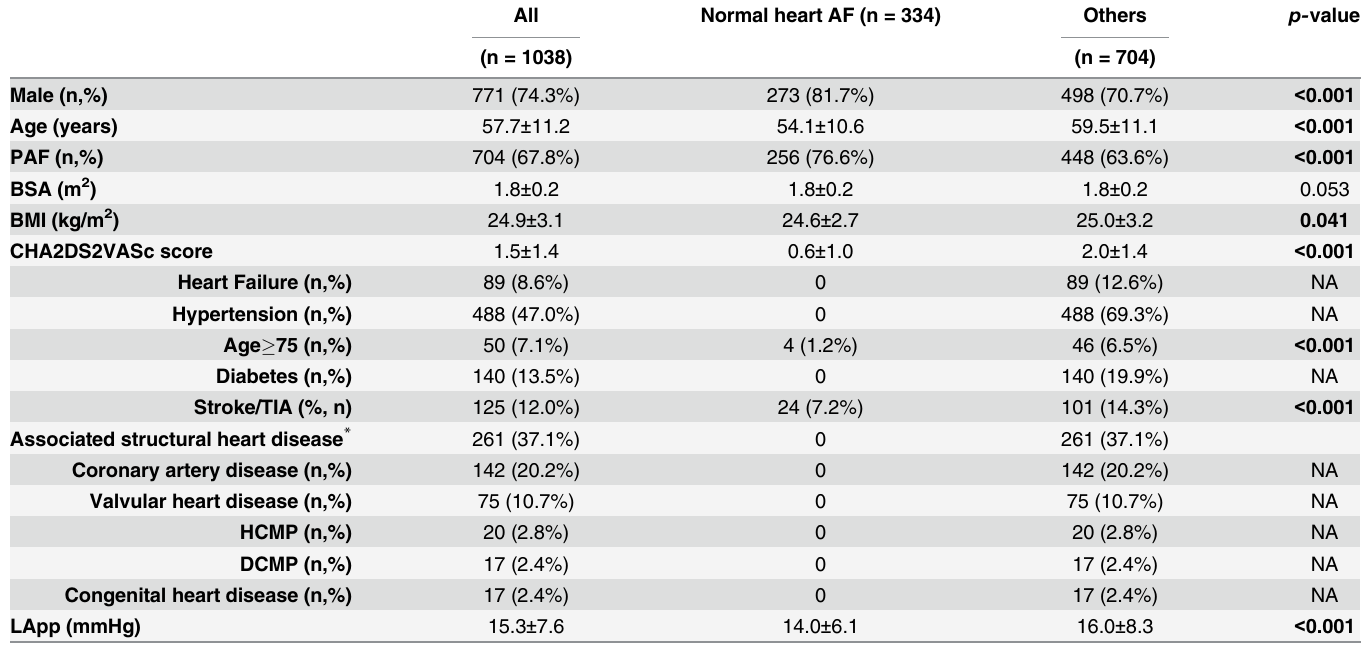
Table 1. Clinical characteristics of